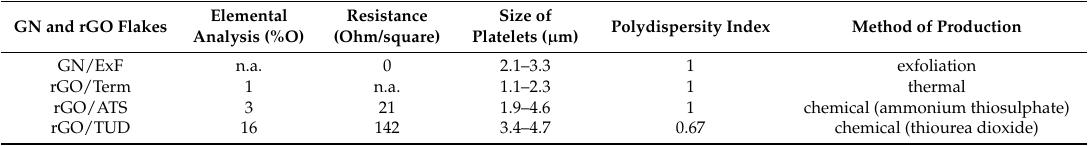
Table 1. Physicochemical properties of the GN and rGO